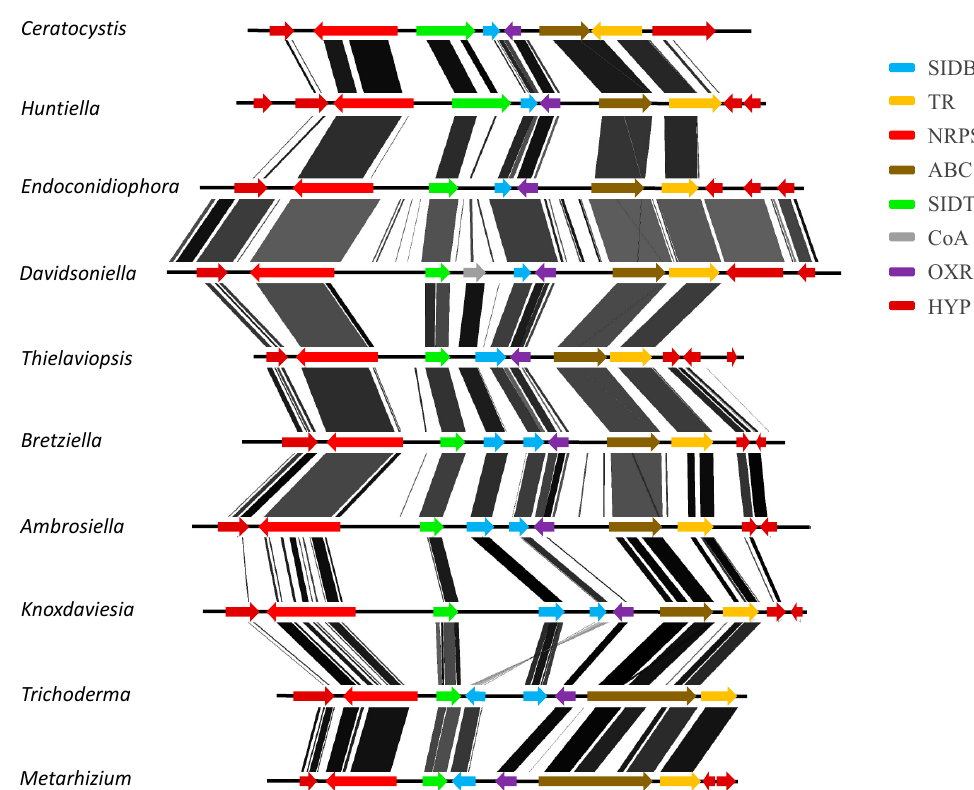
Figure 2. Comparison of the siderophore biosynthesis gene clusters of Ceratocystidaceae , Trichoderma virens, and Metarhizium anisopliae . OXR, oxidoreductase; TR, transporter; HYP, hypothetical protein; SIDB, siderophore biosynthesis protein; SIDT, siderophore transporter; ABC, ABC transporter; NRPS, nonribosomal peptide synthetase; CoA, co acetyl transferase. Shaded lines represent similarities between nucleotide sequences. The figure was generated using EASYFIG version 2.2.2 (http: // mjsull. github.io / Easyfig / files.html) and the GenBank information for each